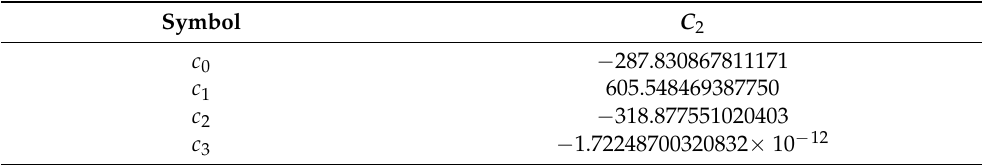
Table A1. The coefficient set of two-order controller.